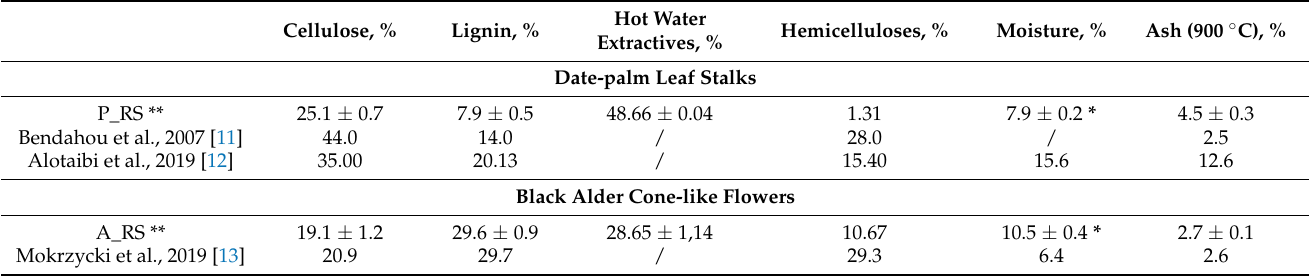
Table 1. Lignocellulose composition of raw samples of